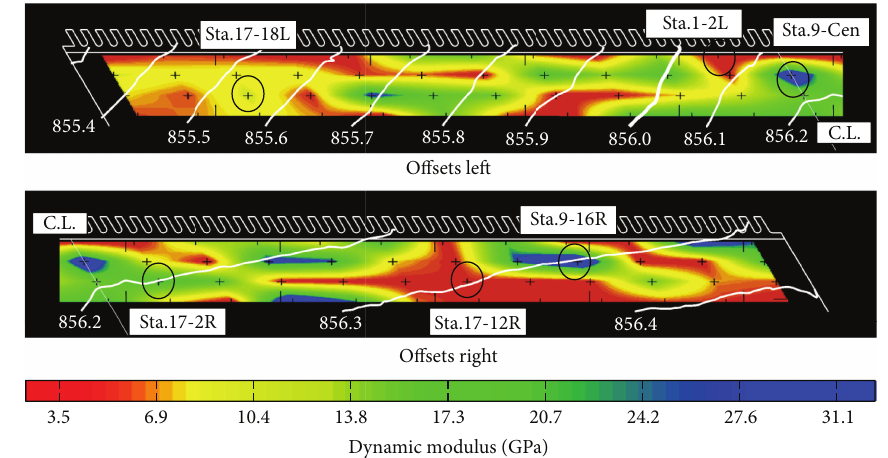
Figure 5: Contour maps of PSPA results and locations of core samples taken in this study.